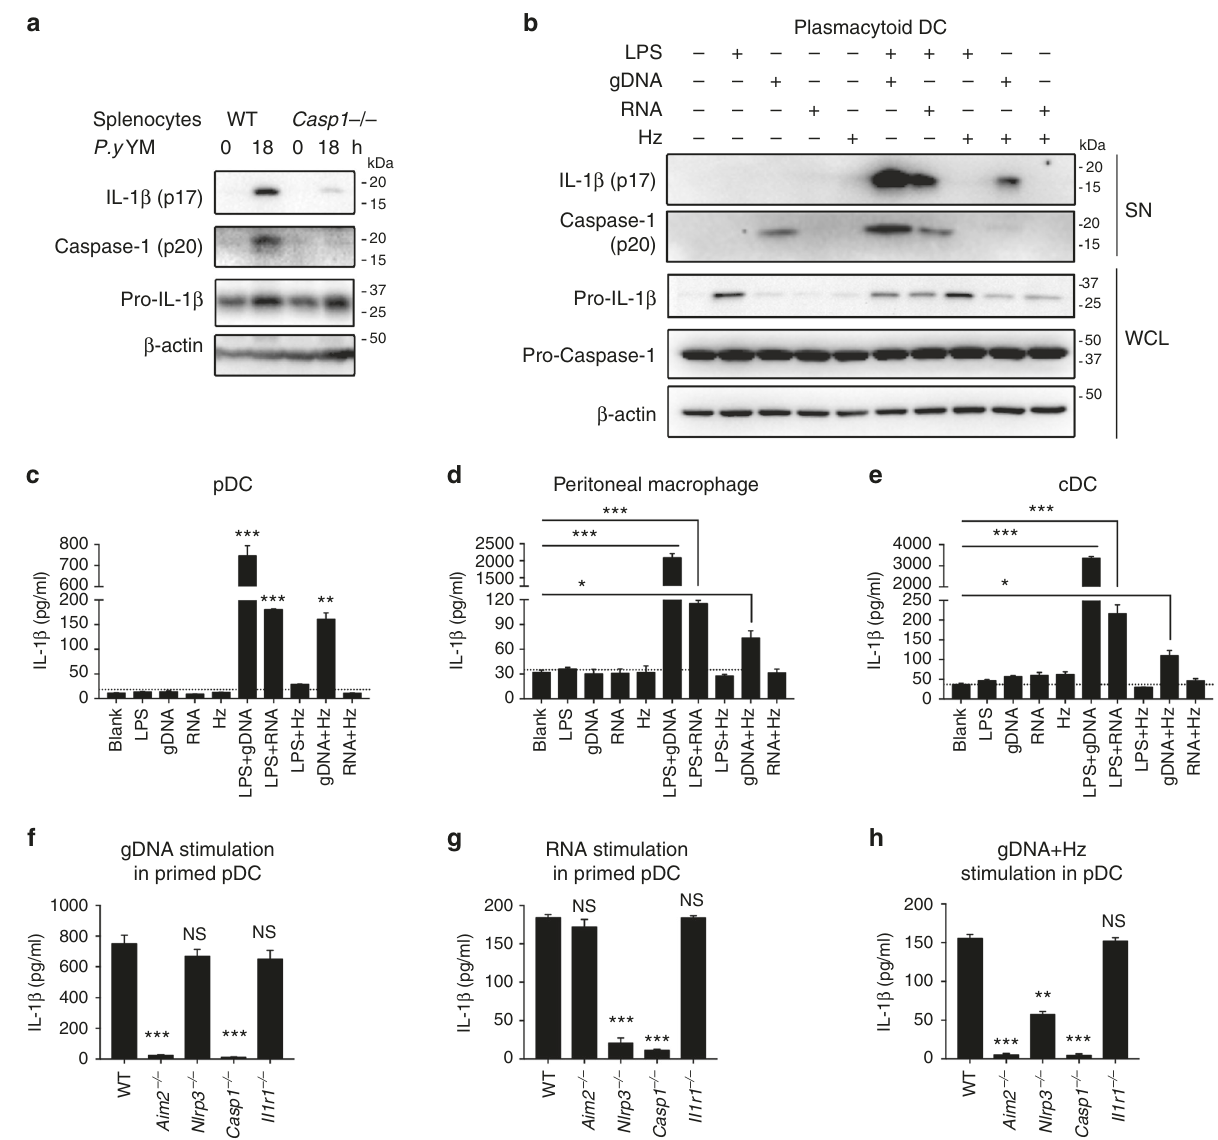
Fig. 2 Plasmodium gDNA activates innate immune AIM2 in fl ammasome, while RNA and hemozoin trigger NLRP3 in fl ammasome activation. a WT and Casp1 − / − mice ( n = 5) were infected with P. yoelii YM, and splenocytes were harvested at 18 h after infection. Uninfected samples served as control group. Cell lysates were analyzed by immunoblotting with the indicated antibodies. b , c WT pDCs were stimulated as indicated for 24 h, cell lysate and supernatants were collected for immunoblotting analysis ( b ), and supernatants were collected for quantization of IL-1 β cytokine by ELISA analysis ( c ). d , e WT peritoneal macrophages ( d ) and cDCs ( e ) were stimulated as indicated for 24 h, and supernatants were collected for quantization of IL-1 β cytokine by ELISA analysis. f , g LPS-primed WT, Il1r1 − / − , Aim2 − / − , Nlrp3 − / − and Casp1 − / − pDCs were stimulated with gDNA ( f ) or RNA ( g ) for 24 h, and supernatants were collected for quantization of IL-1 β cytokine by ELISA analysis. h WT, Il1r1 − / − , Aim2 − / − , Nlrp3 − / − , and Casp1 − / − pDCs were stimulated with gDNA/hemozoin complex for 24 h, supernatants were collected for quantization of IL-1 β cytokine by ELISA analysis. Data are representatives of three independent experiments with similar results and plotted as mean ± SD. * p < 0.05, ** p < 0.01 vs. corresponding control. NS, not signi fi